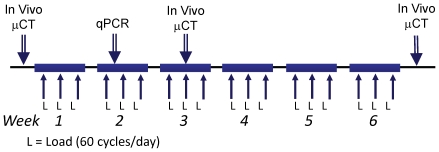
Study timeline.Mice were loaded 3 days/wk.